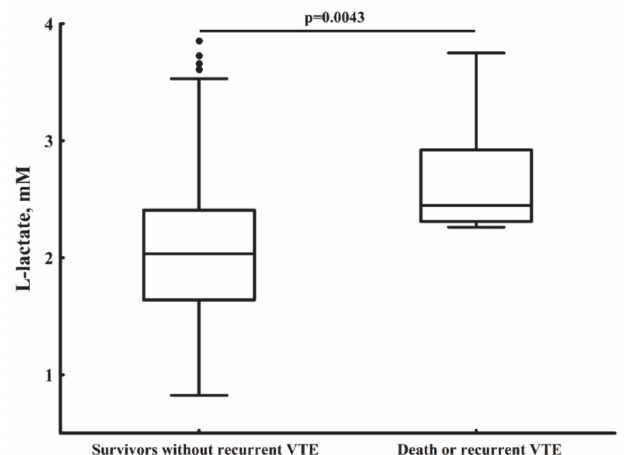
Figure 2. Plasma lactate levels assessed on admission in survivors without recurrent venous thromboembolism (VTE) vs. patients who died due to acute pulmonary embolism or its complications or experienced recurrent VTE during 1 year